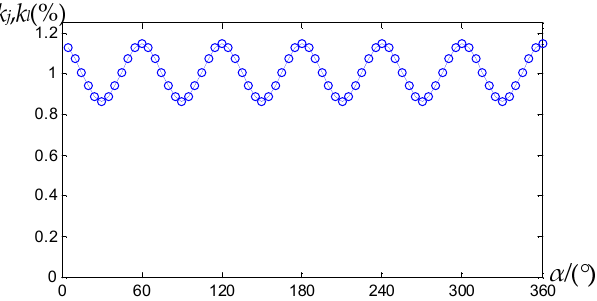
Figure 7. The distribution of the second harmonic ratio with the closing angle when the three-phase remanence is remanence is zero.